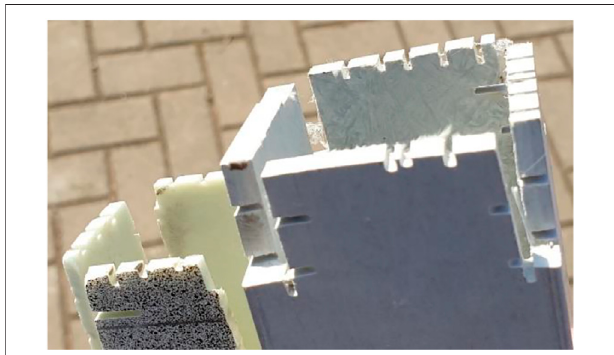
FIGURE 2 | The GFRP pro fi les after cutting the samples for the heating tests.